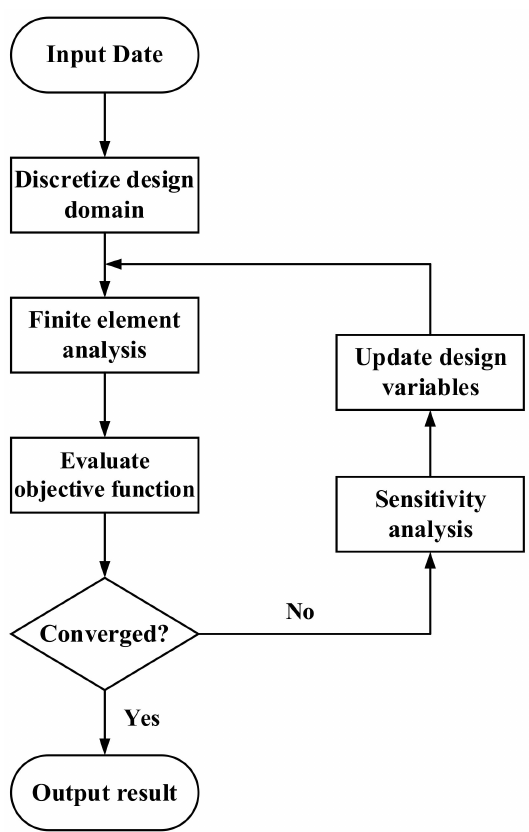
Figure 1. Topology optimization